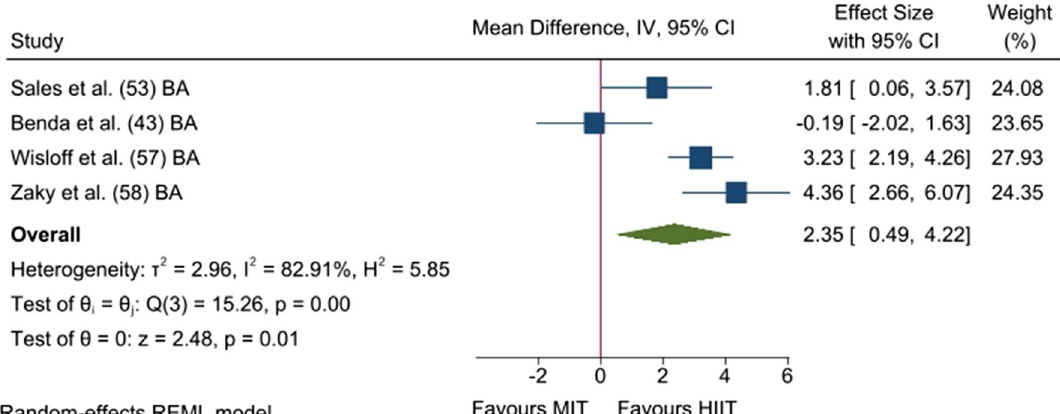
Fig. 4 Forest plot of mean differences between high‑intensity interval training and moderate‑intensity training for relative flow‑mediated dilation. BA, brachial artery; CI, confidence interval; HIIT, high‑intensity interval training; IV, inverse variance; and MIT, moderate‑intensity